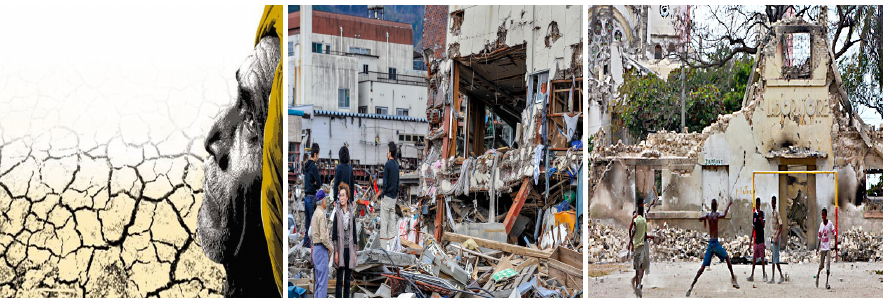
Figure 1. Sample images of natural disasters for sentiment analysis showing the diversity in the content and information to be